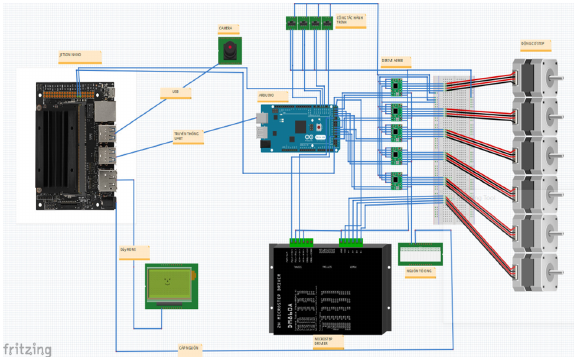
Fig. 8. The hardware structure of the control block of the waste sorting robot arm